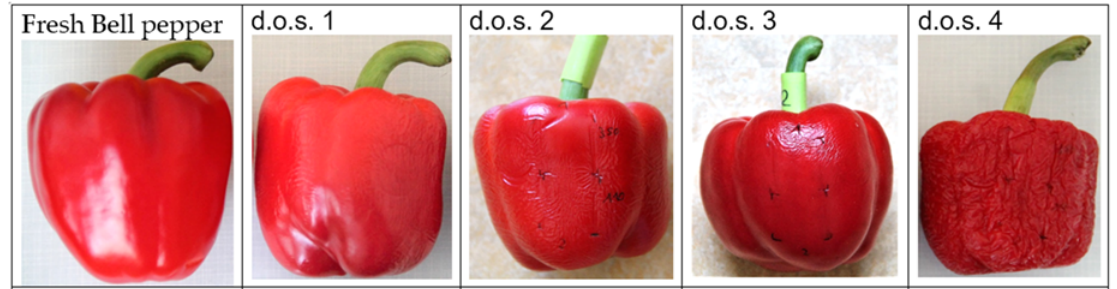
Figure 1. Our designation of shriveling of the bell pepper fruit deployed for the experiment defined as degree of shriveling (d.o.s.).